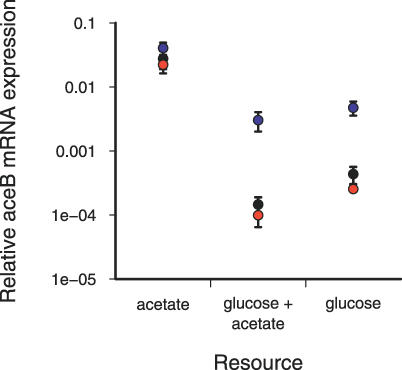
Relative mRNA Expression from the aceB Gene
aceB mRNA expression was quantified using quantitative PCR and normalized against 23SrRNA-4 ribosomal mRNA expression.RNA was isolated from cells in early log growth during the first phase of diauxie when glucose was present. In glucose-containing media, the FS has significantly higher aceB expression than the Anc and SS (F8,18 = 16.26, p < 0.0001; Tukey HSDFS,SS
p = 0.032). Symbols: Anc (black), SS (red), and FS (blue).